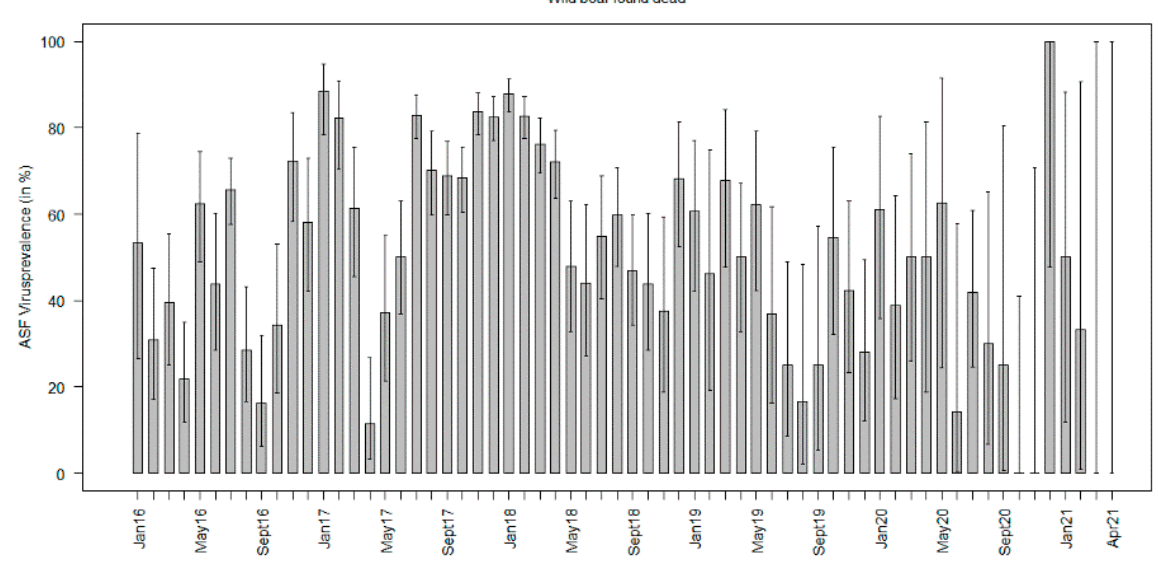
Figure 4. African swine fever virus prevalence estimates per month in wild boar found dead between January 2016 and November 2020.